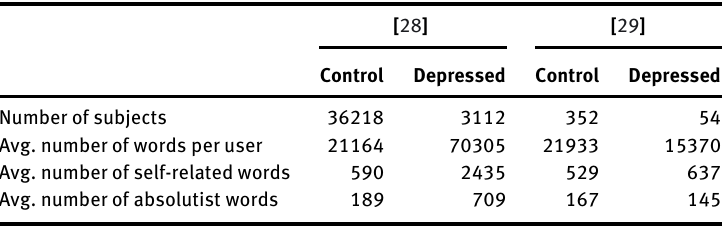
Table 3: Statistics of the test datasets.